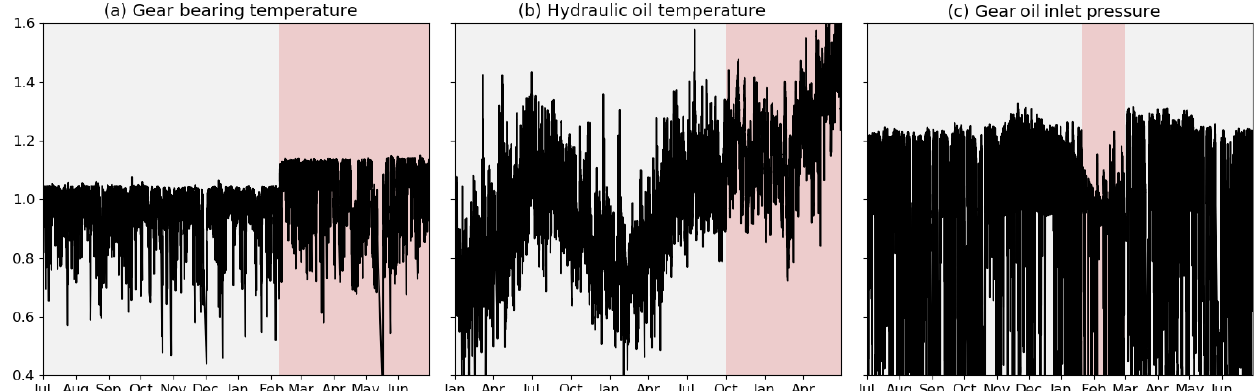
Figure 3. Exemplary SCADA signals exposing different structural changes. Each change in background colour indicates a CP.